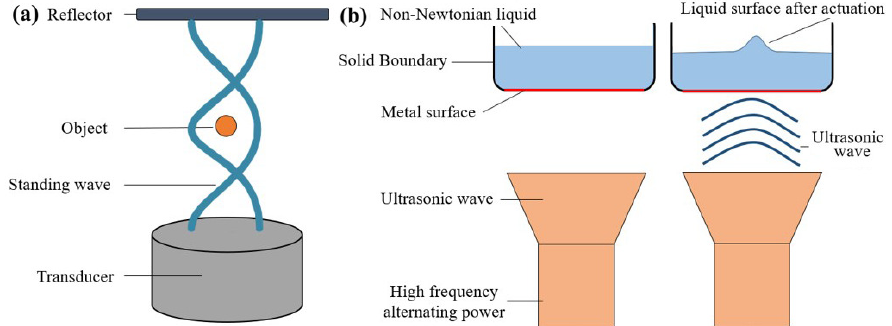
Figure 8. ( a ) Schematic of an object suspended by a standing wave. ( b ) Schematic diagram of a non-Newtonian liquid actuated by an ultrasonic